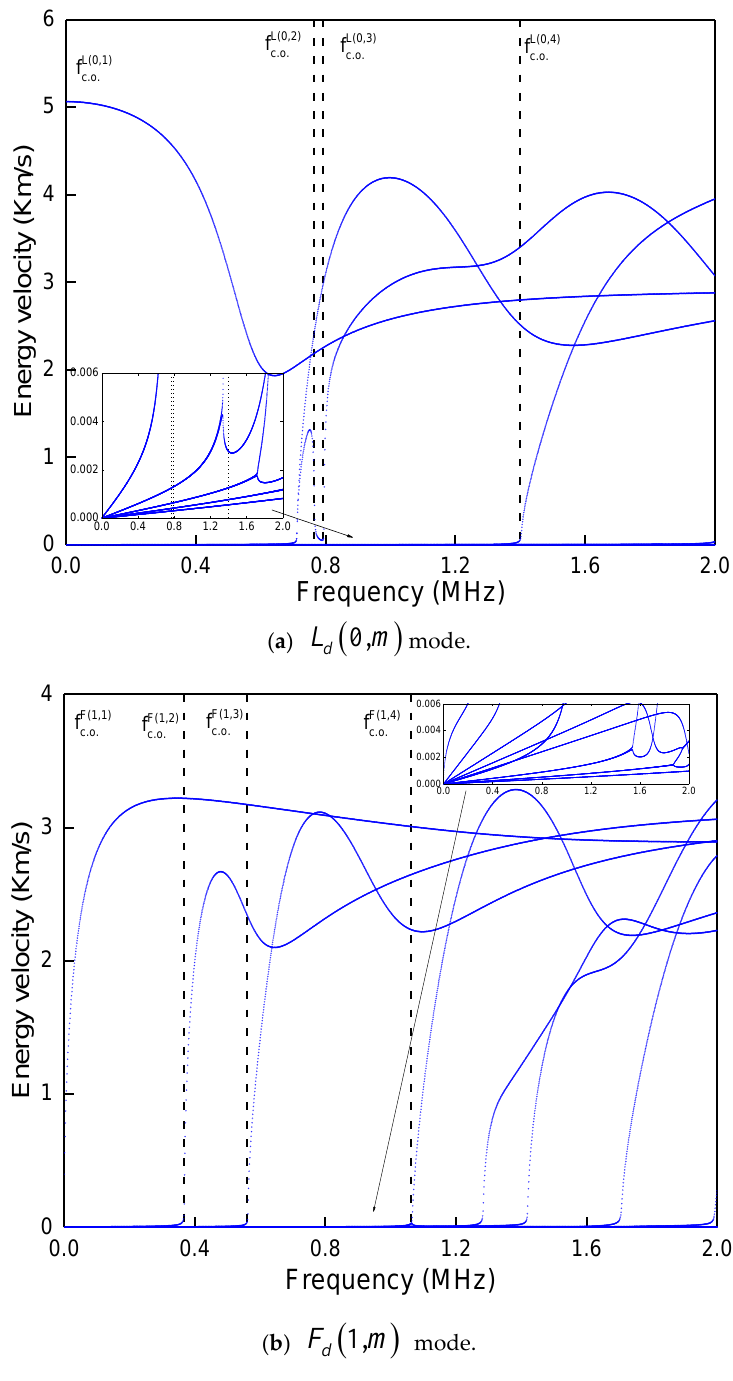
Figure 13. Energy velocity dispersion curve: ( a ) L d ( 0, m ) mode; ( b ) F d ( 1, m )